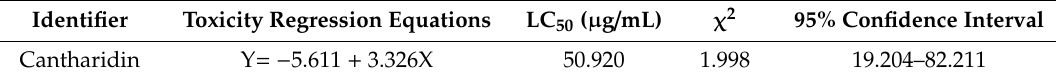
Table 4. Toxicity determination of e ff ective compounds on P. americana (48